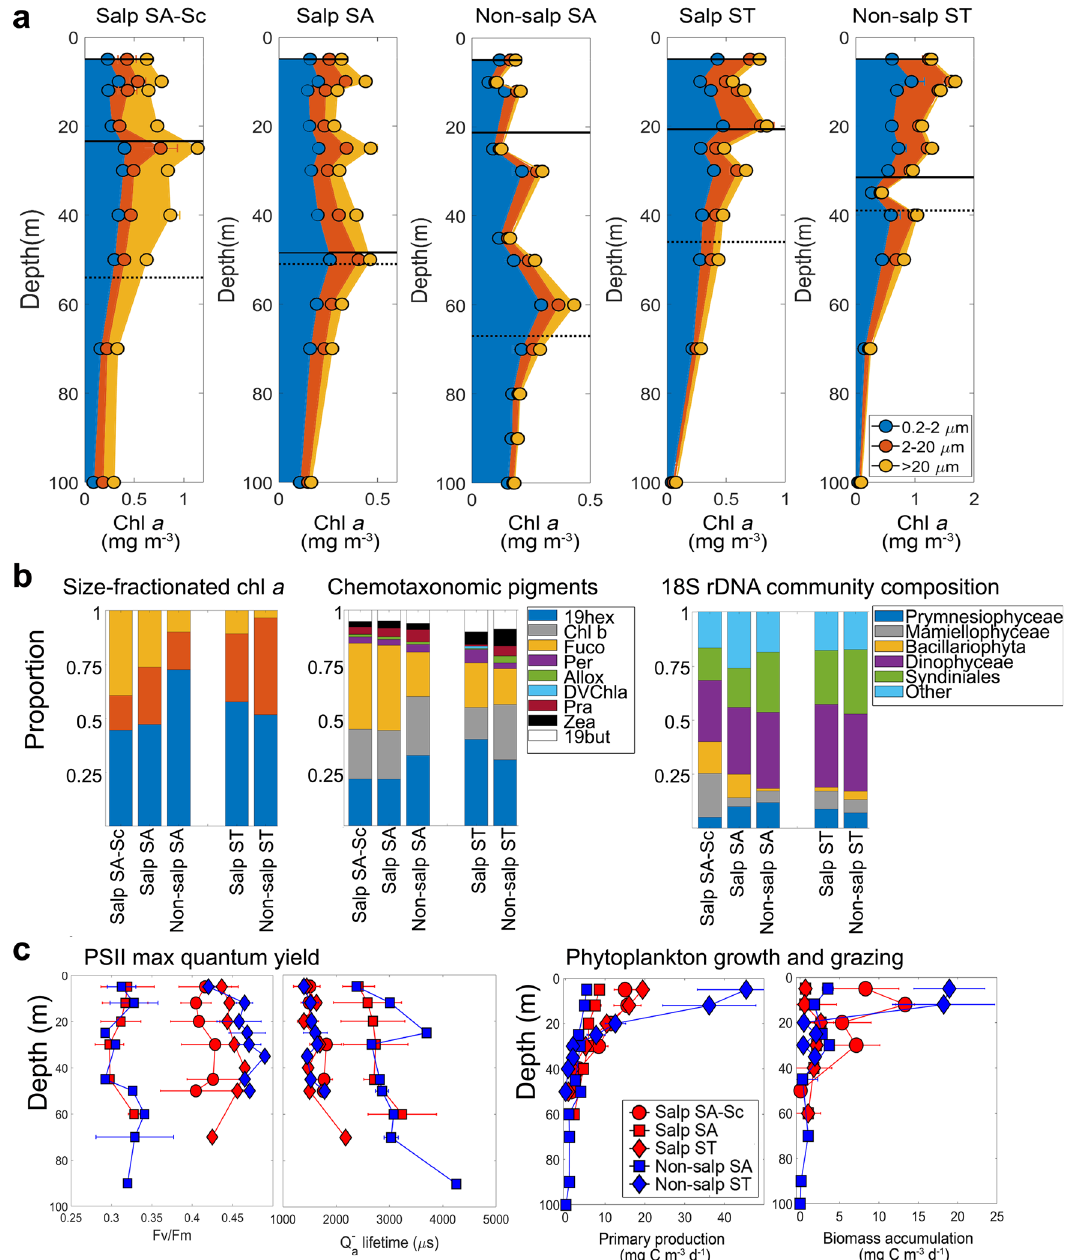
Fig. 2 | Phytoplankton community metrics. a Depth-resolved size-composition (0.2 – 2 µ m, 2 – 20 µ m, >20 µ m) of chlorophyll a (see legend for colors) for each experimental cycle. Note different scales on x axis. Mixed layer is denoted by the straight line (shallower depth), and euphotic zone (0.1% PAR) by the dashed